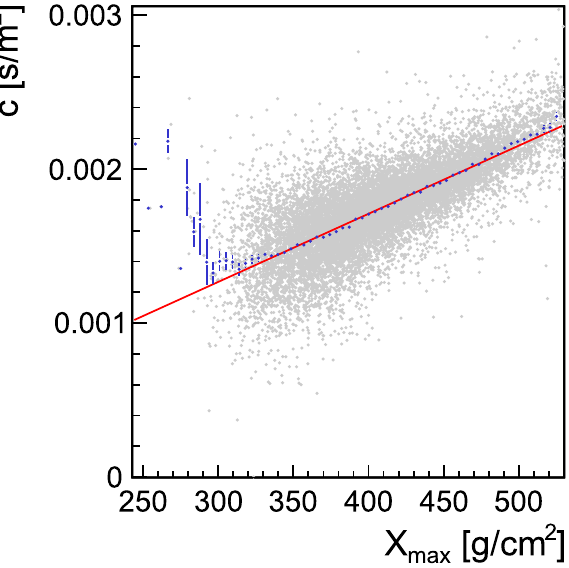
Fig. 7 Correlation of the c curvature parameter with the slant depth of themaximumofthelongitudinalprofile, X max .SeeEq.6foradefinition of the c parameter (see text for the simulation